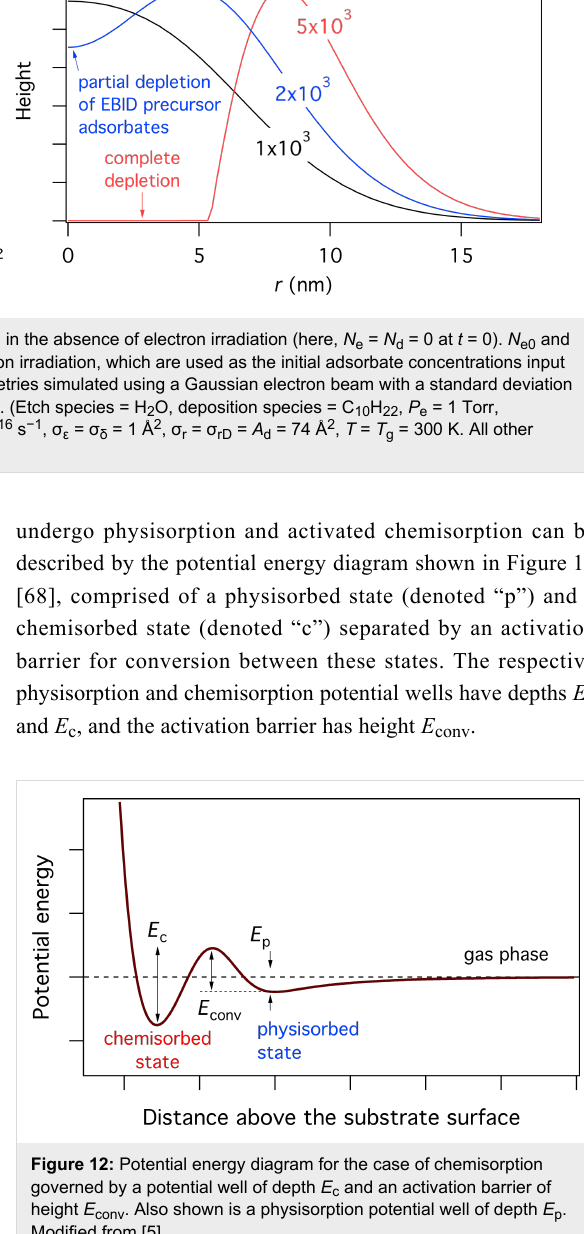
Chemisorption is typically a dissociative process in which the activation barrier represents the energy needed to fragment the precursor molecule. For example, O 2 chemisorbs onto numerous surfaces through the thermally activated reaction O 2 → 2O, where O 2 is in the gas phase or in the physisorbed state, and the two O atoms are in the chemisorbed state. Simi- larly, XeF 2 can fluorinate many surfaces through decomposi- tion pathways that generate chemisorbed F [17,69-71], and the FEBID precursor tetraethyl orthosilicate (TEOS, Si(OC 2 H 5